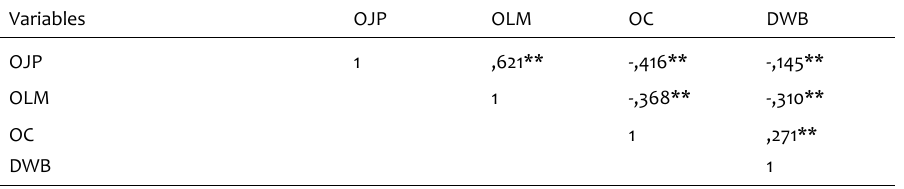
Table 2. Pearson Correlation Analysis of Variables